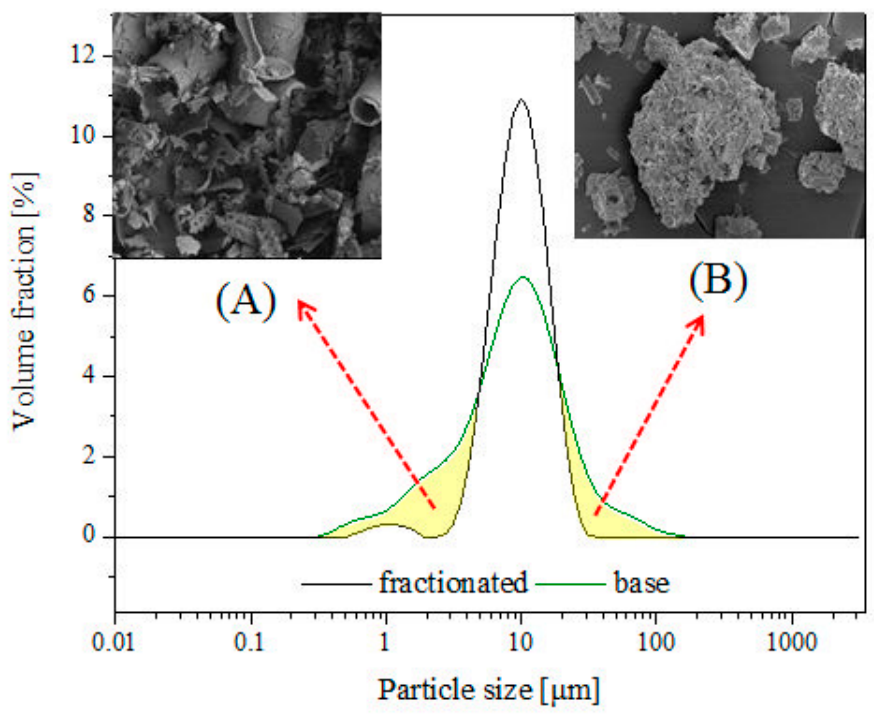
Figure 8. Particle size distribution for ( A ) base and ( B ) fractionated